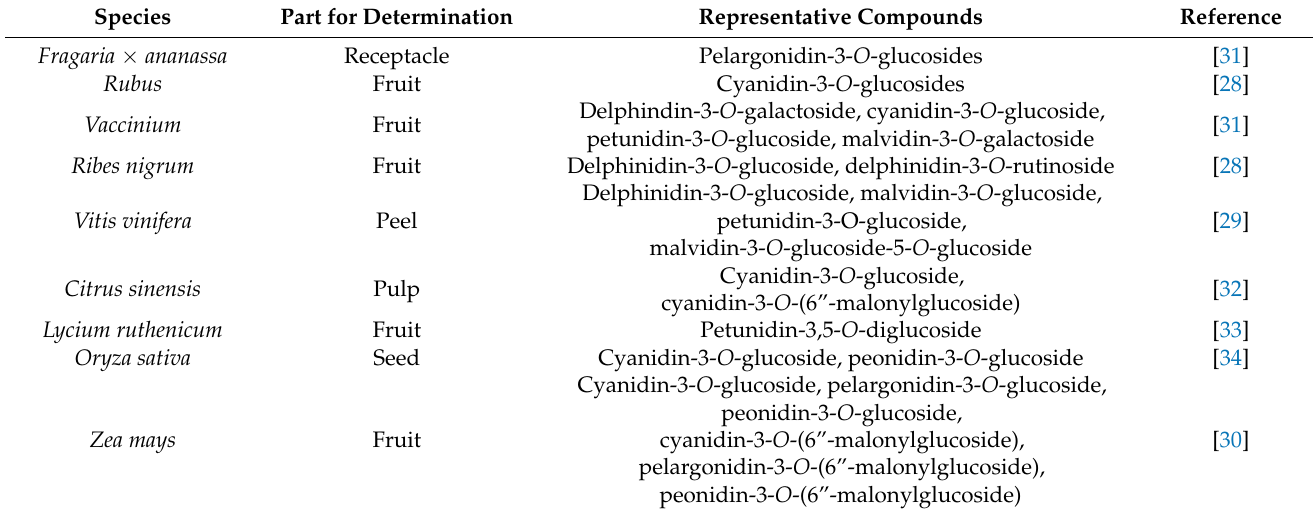
Table 1. Representative anthocyanins in common plant